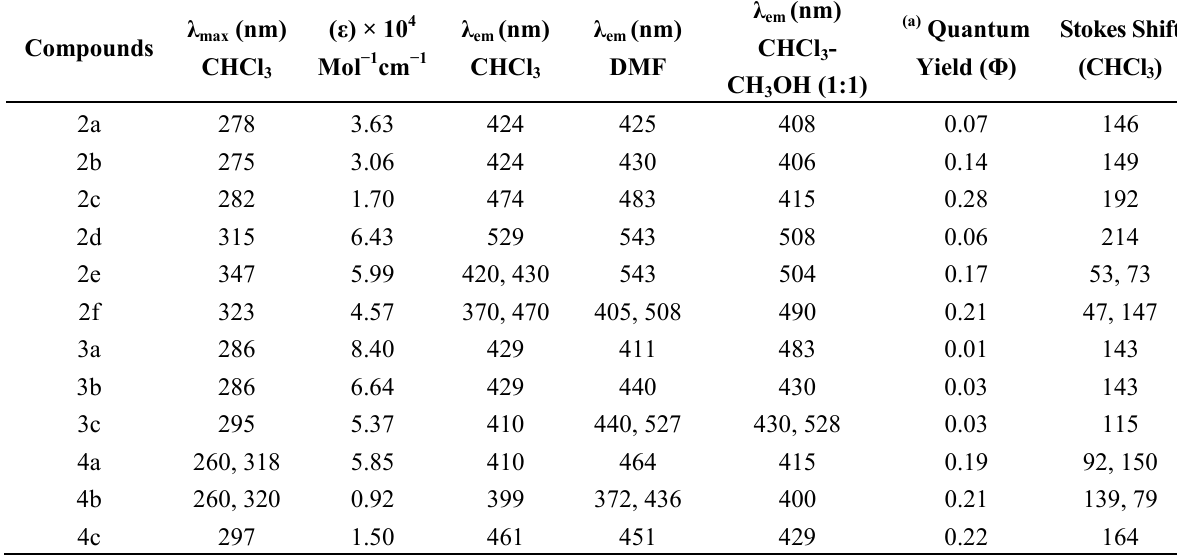
Table 1. The absorption and emission data for compounds 2a – f , 3a – c and 4a – c